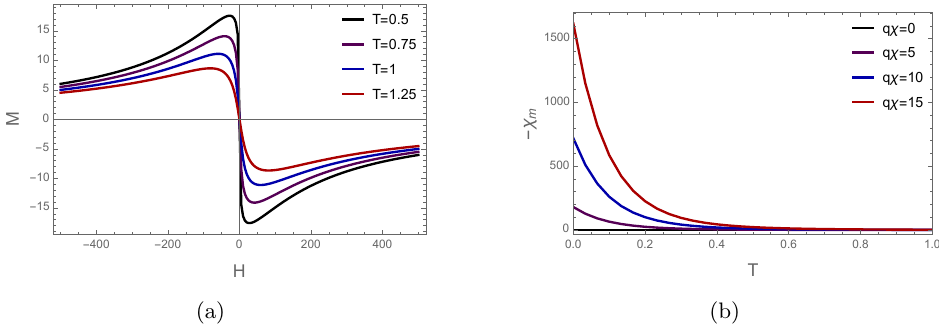
Figure 24 . (a) The external magnetic (cid:12)eld dependence of the magnetization for di(cid:11)erent tem- perature. We (cid:12)x (cid:21) = 2, (cid:11) = 0, q (cid:31) =10 and q = 0. (b) Temperature dependence of the magnetic susceptibility at H = 0 with di(cid:11)erent value of q (cid:31) with (cid:21) = 2, (cid:11) = 0 and q = 0. We interpret (cid:21) 2 as the magnetic impurity density and q each magnetic